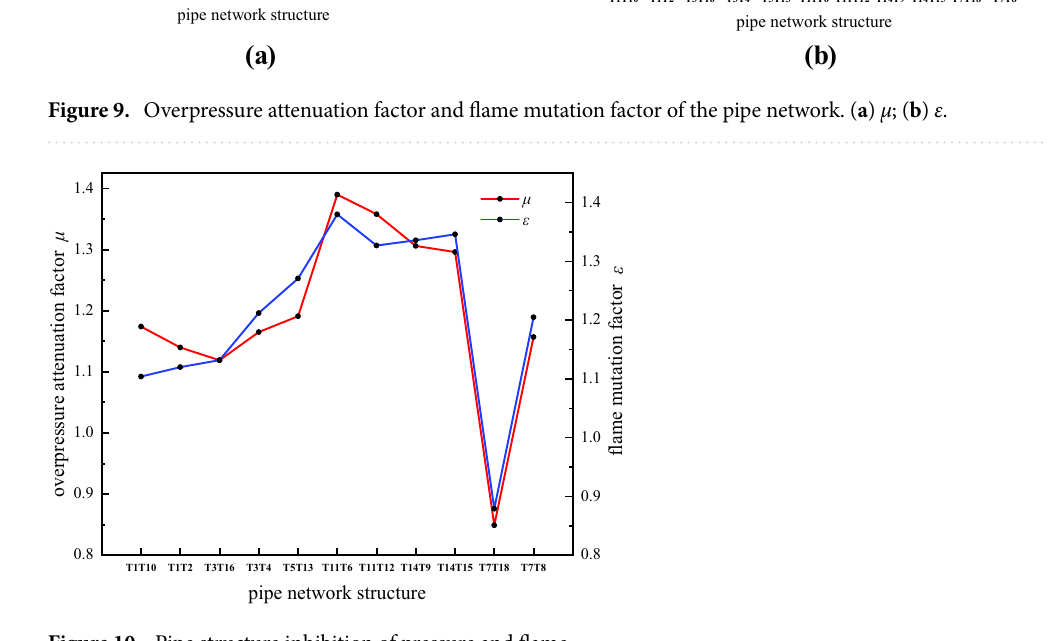
Figure 10. Pipe structure inhibition of pressure and